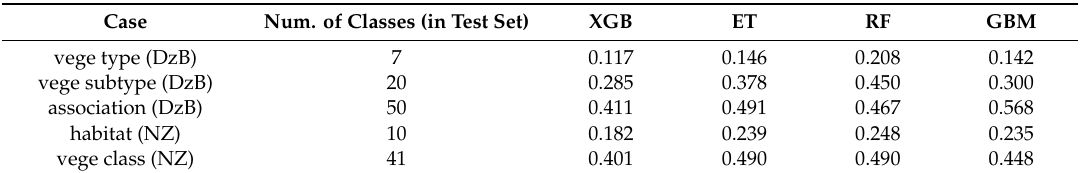
Figure 7. Comparison of OA ( ± standard deviation ( SD)) of different machine learning (ML) models. The selected models include extreme gradient boosting (XGB), extra trees (ET), random forest (RF), gradient boosting machine (GBM), quadratic discriminative analysis (QDA), support vector machine (SVM), and k-nearest neighbors (kNN). Table 2. Mean uncertainty values of vegetation mapping using extreme gradient boosting (XGB), extra trees (ET), random forest (RF), and gradient boosting machine (GBM).